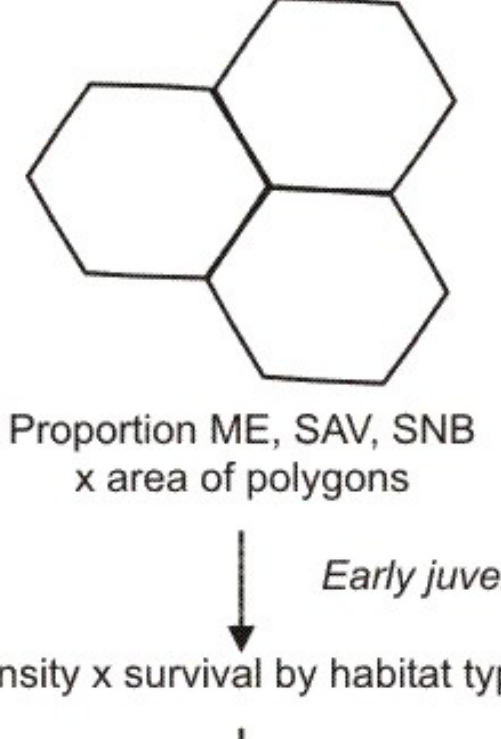
Fig. 2. Schematic diagram of the habitat model for estimating effects of habitat change on the blue crab fishery. ME = marsh edge; SAV = submersed aquatic vegetation; SNB = soft, nonvegetated